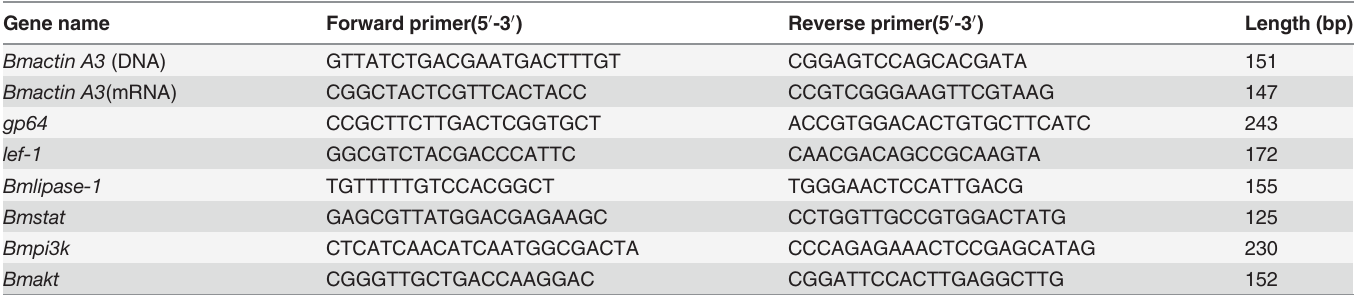
Table 1. Sequences of primers used in quantitative